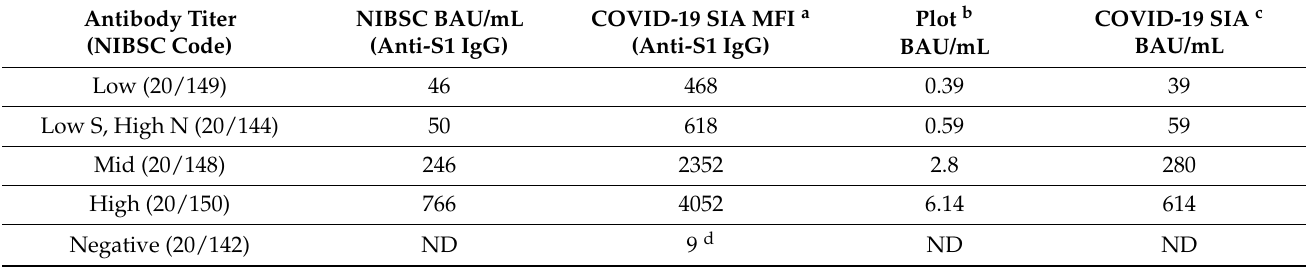
Table 5. Titer comparison of the WHO international reference panel for anti-SARS-CoV-2 immunoglobulins.